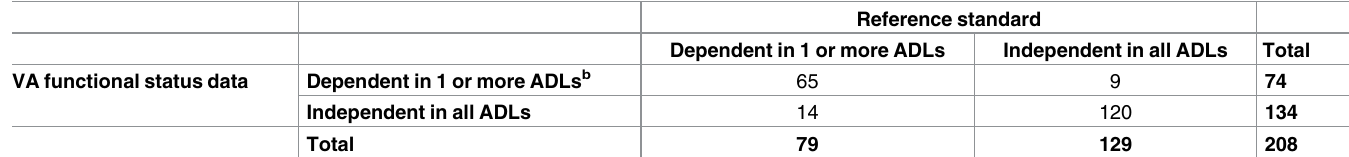
Table 7. Agreement of VA functional status data with the referencestandard of research-collected data for assessing dependence in activities of daily living, among patients with 2–4 weeks elapsed between assessments.